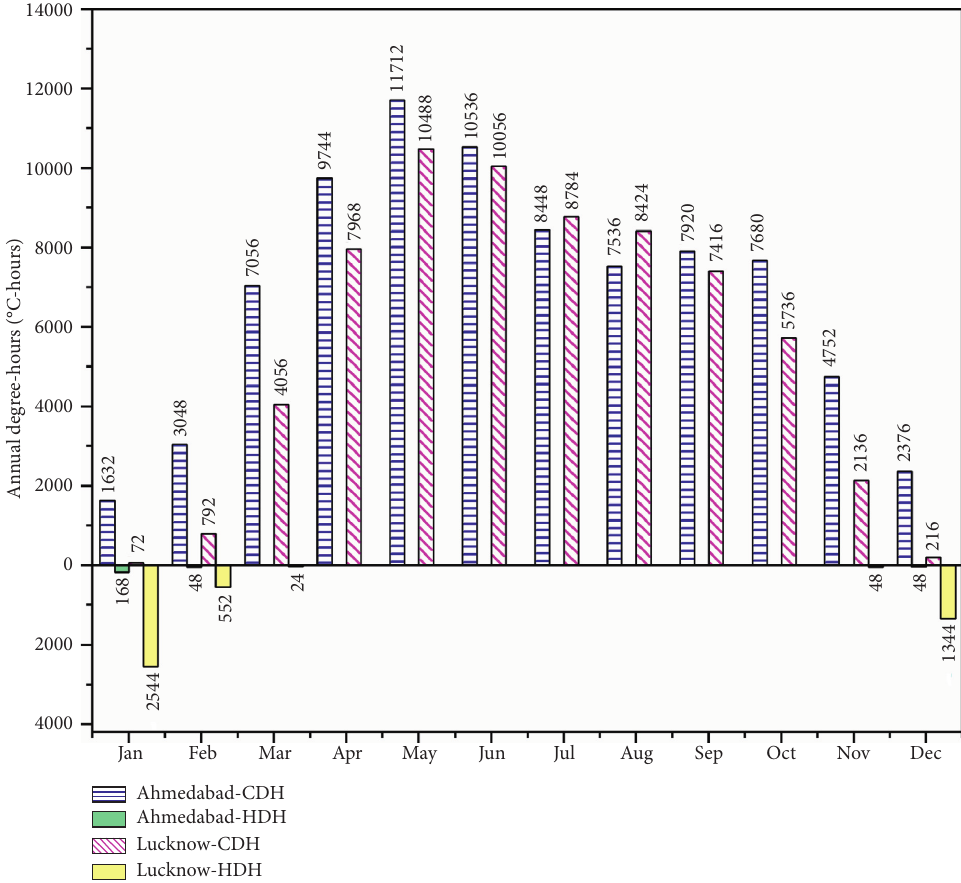
Figure 4: Annual cooling and heating degree-hours in Ahmedabad and Lucknow. Table 2: Elements used for the thermoeconomic